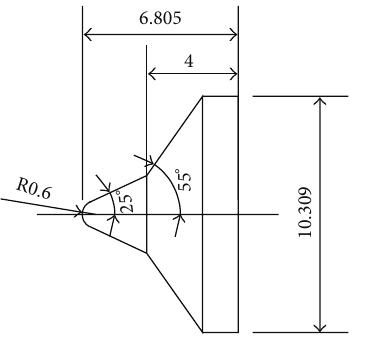
Figure 7: Number 4 configuration (in) (R0.6 blunt nose 25 ∘ /55 ∘